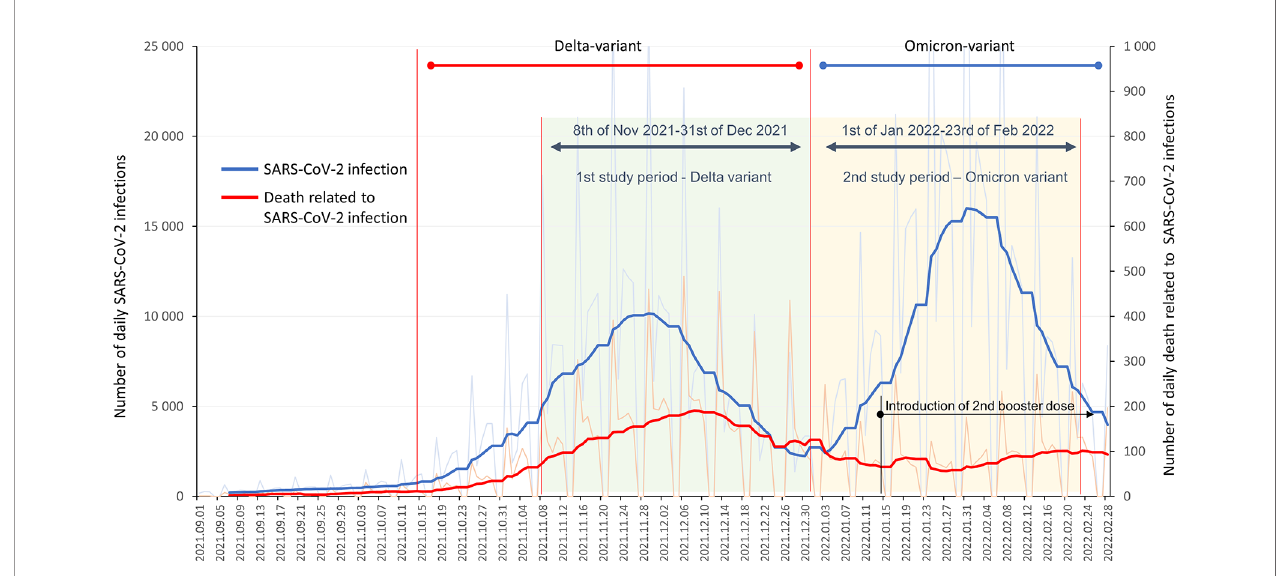
FIGURE 1 | Study periods and timeline of the HUN-VE 2 study together with the reported daily SARS-CoV-2 infections and Covid-19 related mortality in Hungary between 1 September 2021, and 28 February 2022 (source of data: